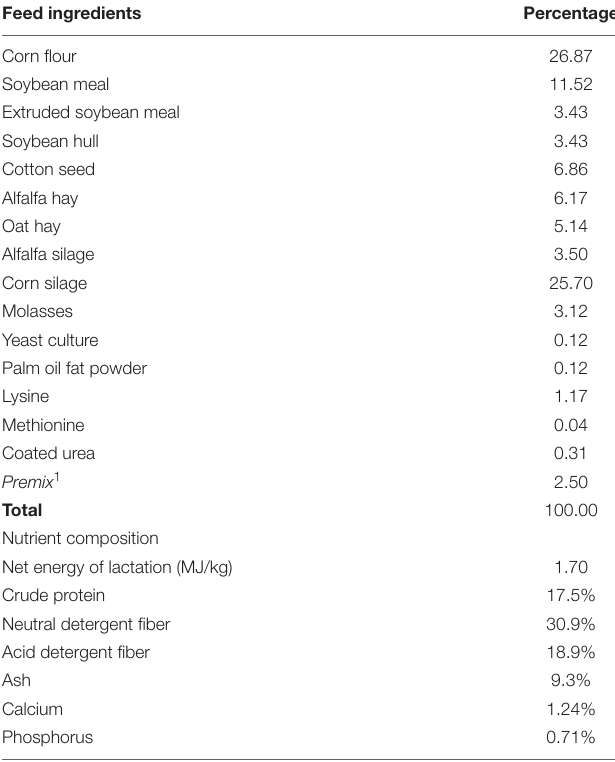
TABLE 1 | Performance and milk composition of cows in HP and LP